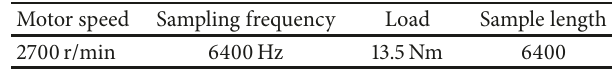
Table 1: Parameters setting of the experiment